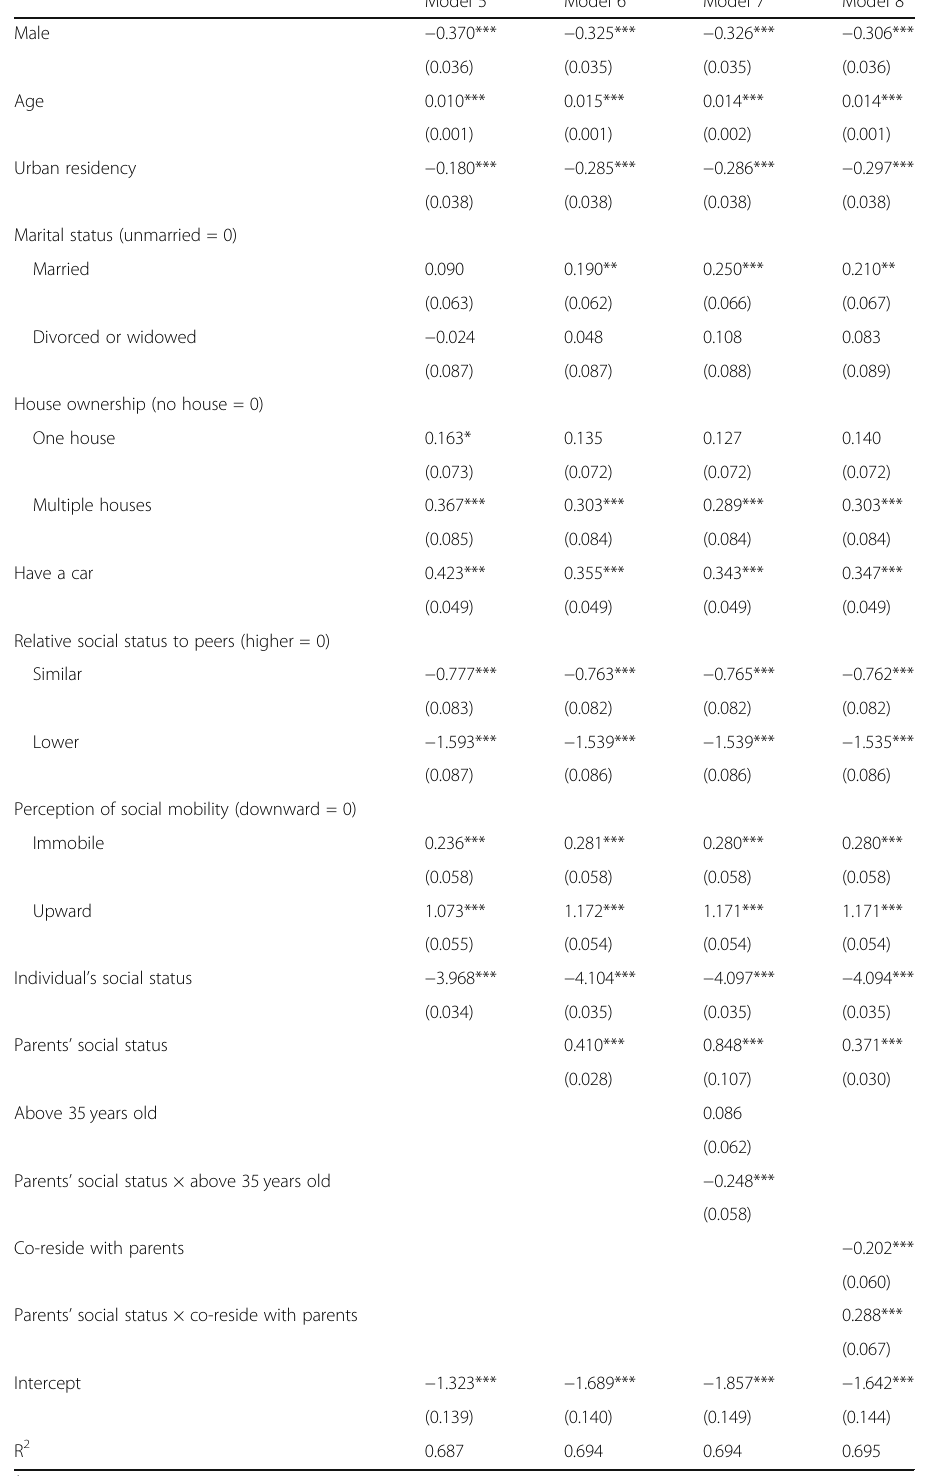
Table 4 The effect of parents ’ social status on children ’ s class identify bias ( N =